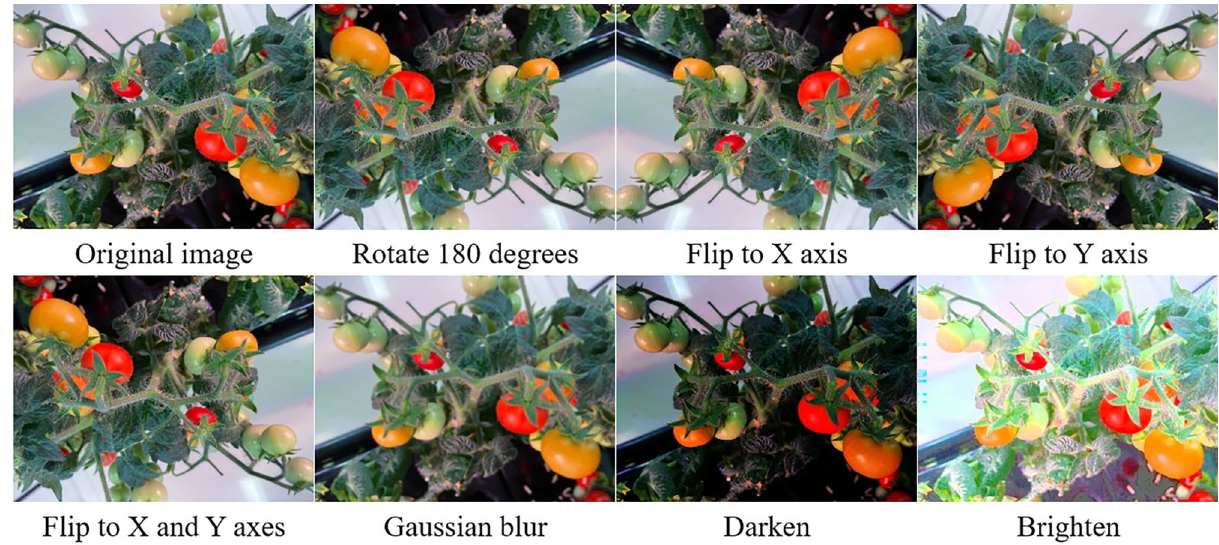
Figure 3. Enhanced illustration of the original image data.